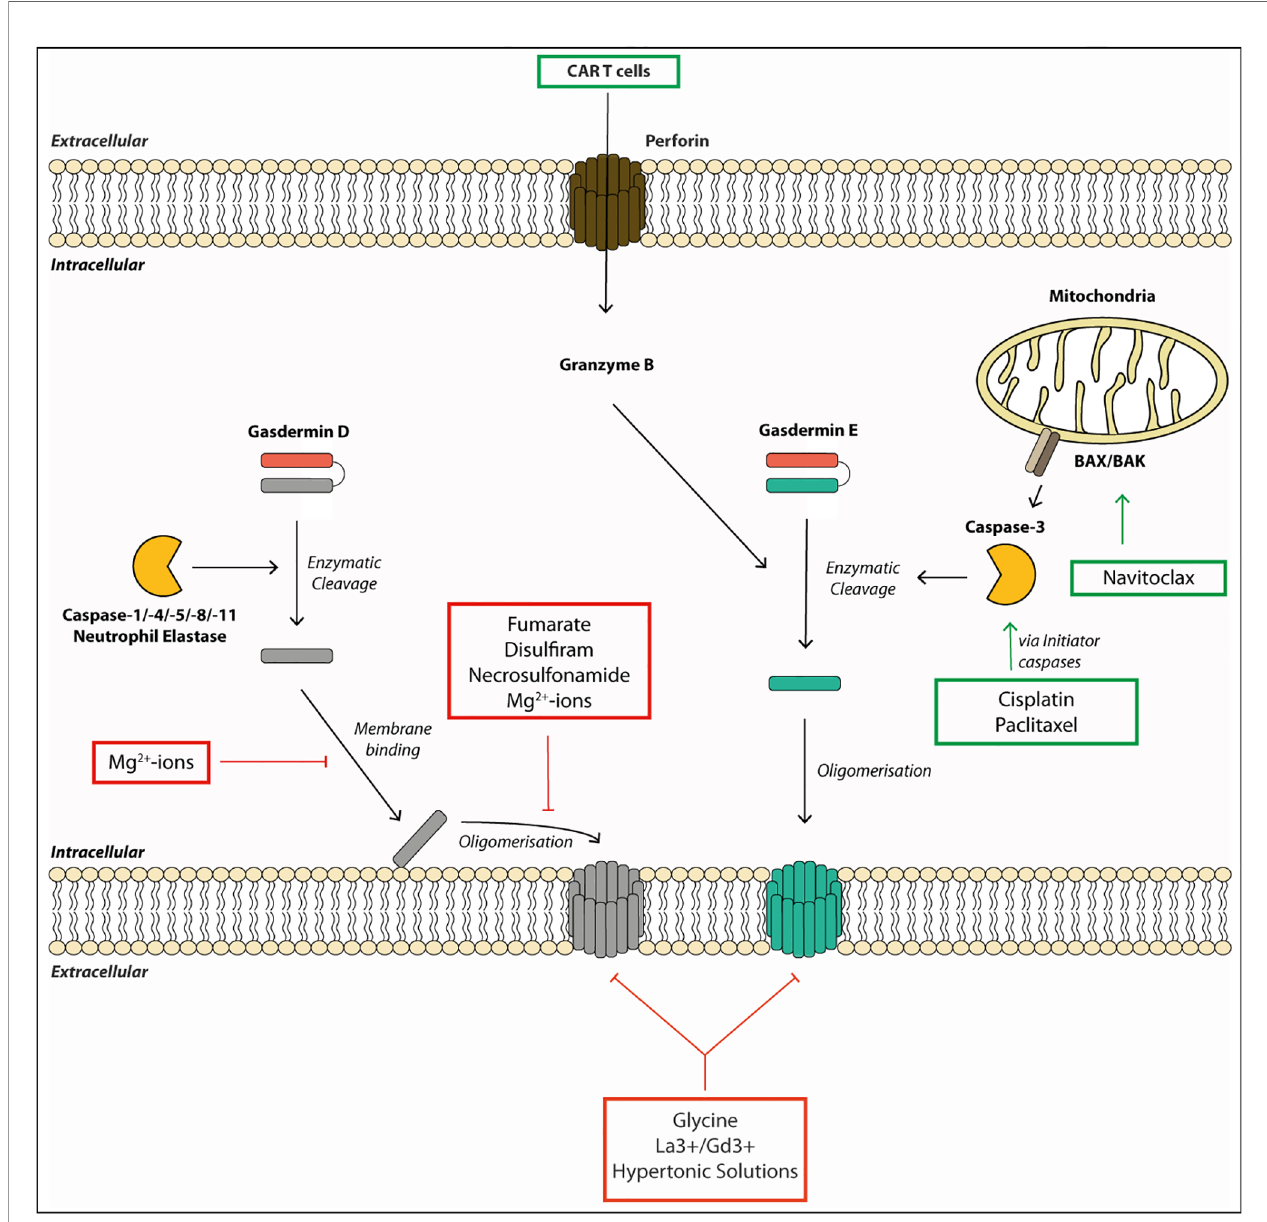
FIGURE 2 | Gasdermin pore formation and cell lysis require multiple steps and can be targeted by therapeutics. Gasdermins are activated by enzymatic cleavage by proteases such as caspases or neutrophil elastase. This liberates the pore-forming N-terminal fragment (GSDM-NT). The GSDM-NT binds to phospholipids on the inner membrane lea fl et. GSDM-NT then oligomerizes to form a membrane pore allowing the ef fl ux of small proteins and ions across the membrane. Gasdermin pores eventually lead to cell death and membrane rupture. Some drugs promote gasdermin-mediated cell death. For example, chemotherapeutic drugs, such as Cisplatin, Paclitaxel or Navitoclax can initiate gasdermin E cleavage. They activate the initiator caspases, which, in turn, lead to gasdermin E cleavage by activating the executioner caspase-3. Other drugs or small molecules can block gasdermin-mediated cell death. For example, the membrane binding and the oligomerization step of gasdermin D can be blocked by Mg 2+ -ions by an unknown mechanism. Fumarate, Necrosulfonamide and Disul fi ram can block oligomerization of gasdermin D by modifying Cys191. Finally, membrane rupture can be blocked by the osmoprotectant glycine, hypertonic solutions or the lanthanide ions La 3+ and Gd 3+